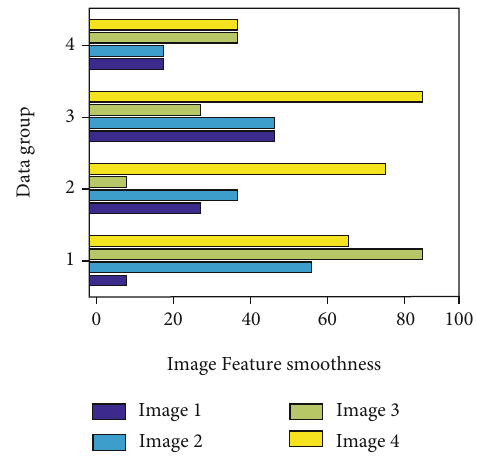
Figure 3: Comparison of smoothness histograms of image